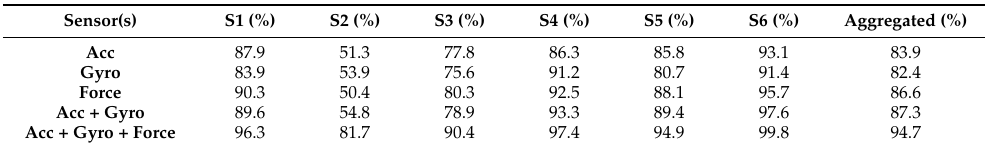
Table 2. Eight-fold cross validation recognition effect of each channel’s sensing information (S1–S6 correspond to RHS, RFF, RFS, LHS, LFF, and LFS, respectively).